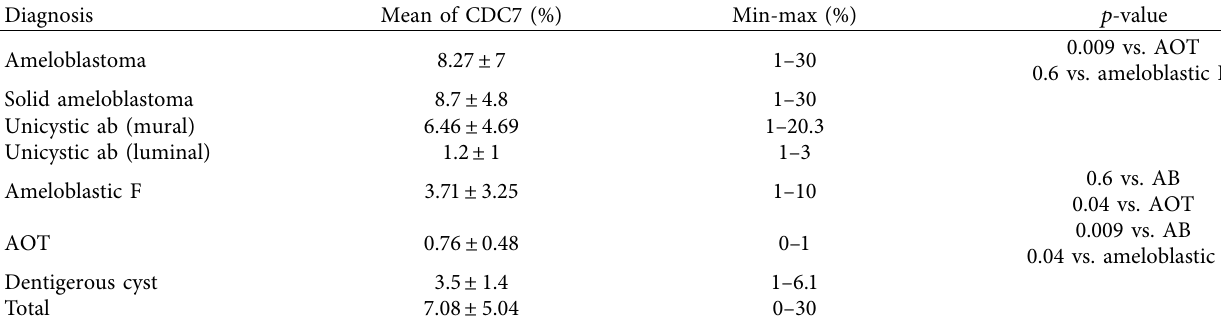
Table 2: CDC7 expression rate in all groups.